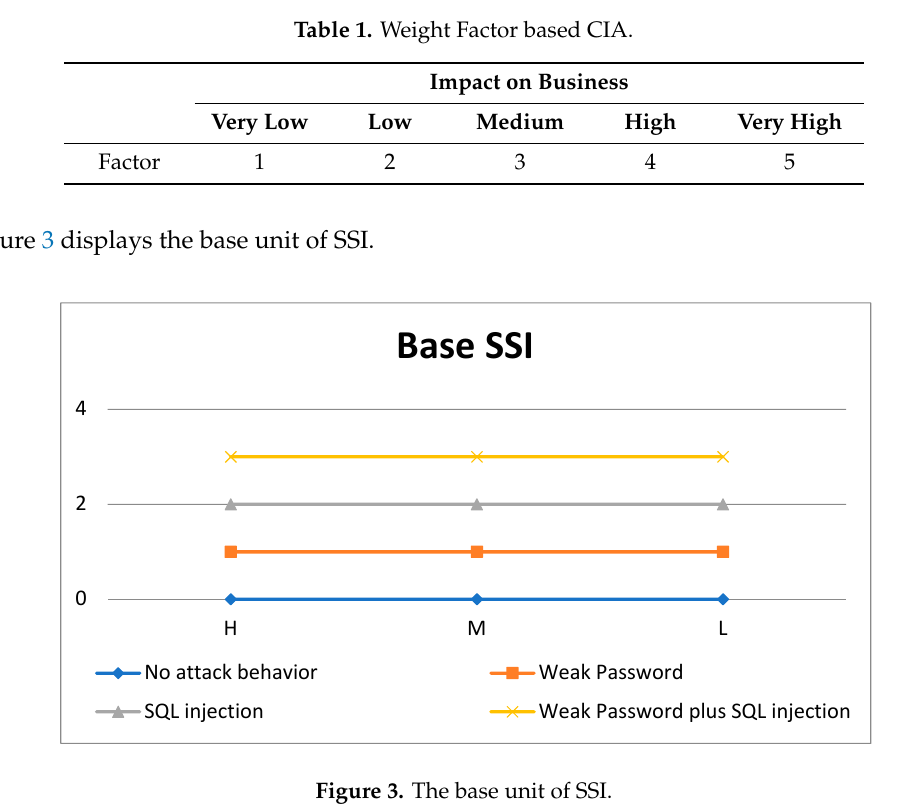
Figure 3. The base unit of SSI.